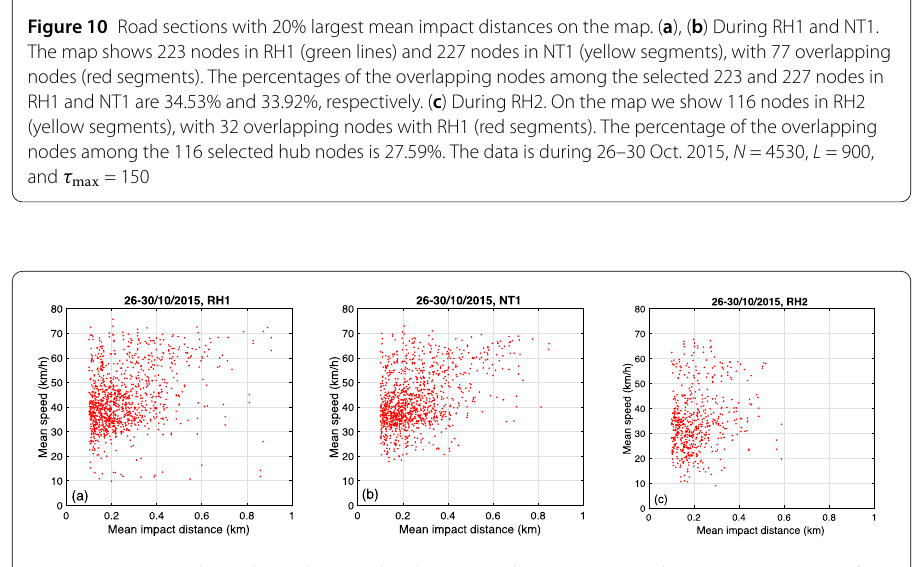
correlation indicates a strong capability of variation transmission, while a very congested or smooth road does not show too much variation. In addition, according to Fig. 12, the weighted degree and the mean impacted distance reflect different angles of the influential